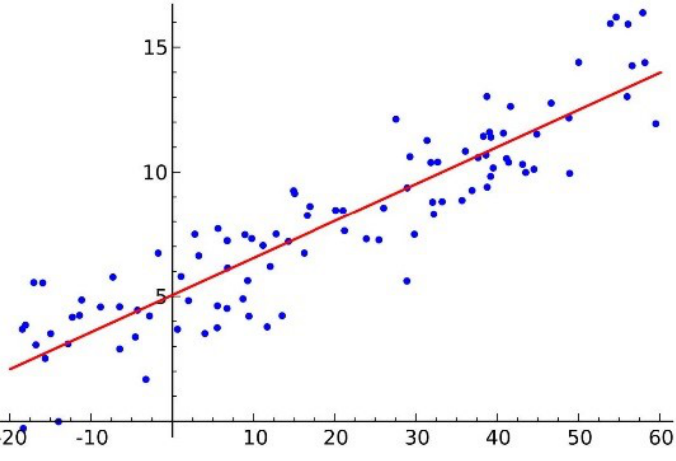
Fig. 2 Wavelet variance of the smooth subgraph of an urban